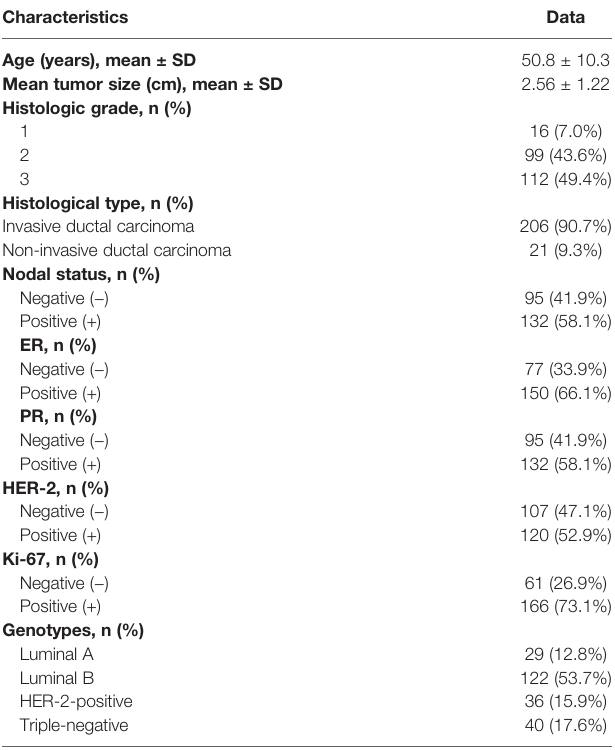
TABLE 1 | Clinicopathological characteristics of the included patients. Characteristics